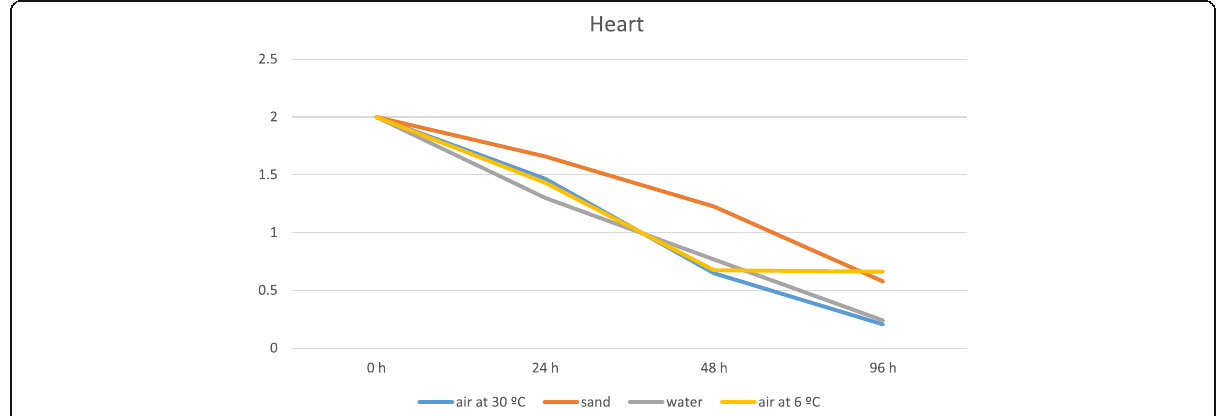
Fig. 2 Mean heart GAPDH relative expression levels in the studied groups after different time